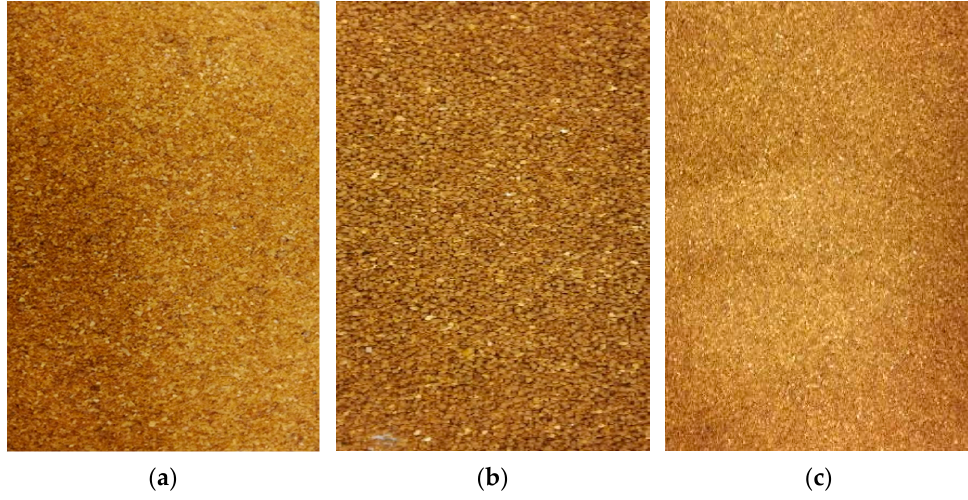
Figure 4. Samples used for different experiments; ( a ) original DDGS; ( b ) #20-sieved aspirated (SA) heavy fraction; ( c ) #40-sieved aspirated (SA) heavy fraction.